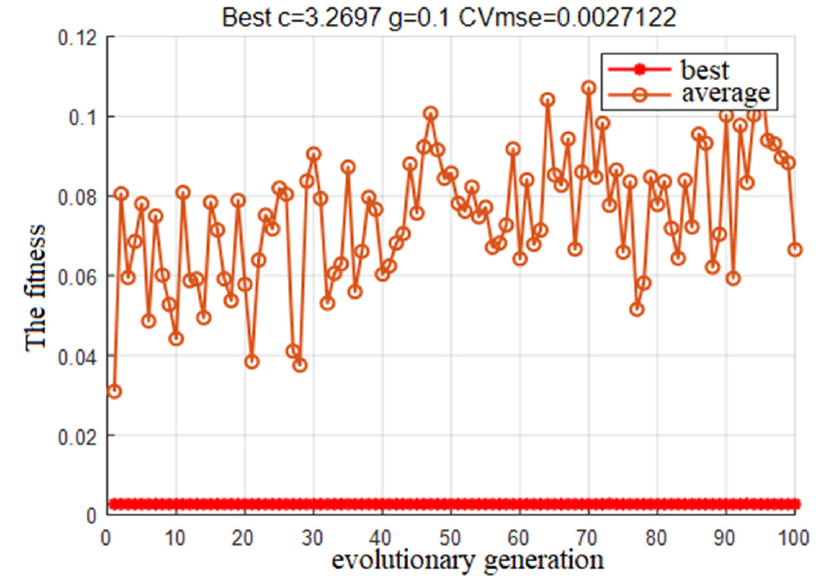
Figure 8. Particle swarm optimization parameter optimization fitness curve.